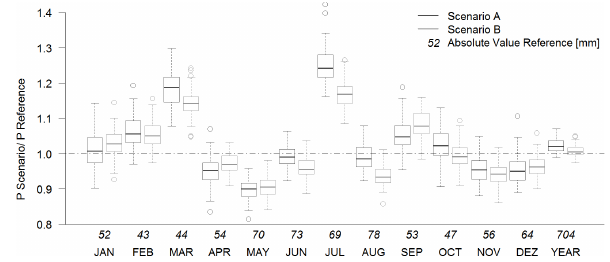
Fig. 4. Ratio between actual evapotranspiration (ETA) for the sce- narios and the reference period, Weisser Schoeps.